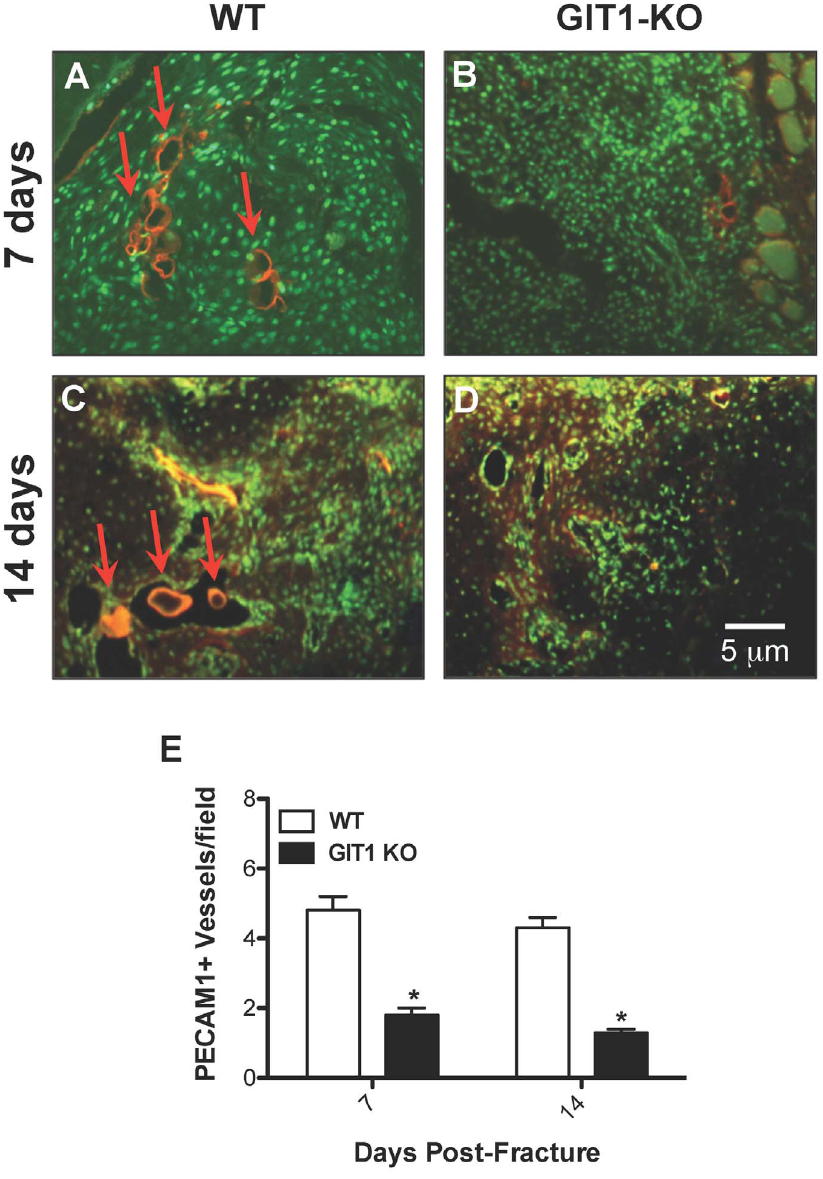
Figure 8. PECAM1 + blood vessel number is reduced in GIT1 KO mice. Representative PECAM1 immunofluorescence is presented at 7 and 14 days post-fracture in WT mice (A and C) and GIT1 2 / 2 mice (B and D). Histomorphometry was performed to quantify the average number of positively- stained blood vessels present in each field of view on each section analyzed. Three sections (from 3 levels within each callus, 25–50 m m apart) were viewed using the 10 6 objective, with counts being collected from 3 fields of view in each section. All counts from each callus (9 fields total) were averaged. Vessel counting using this approach confirmed the immunofluorescence in panels A–D, with WT calluses possessing between 2 and 3-fold more PECAM1 + vessels than GIT1 KO calluses at both time points (E). Bars represent mean number of PECAM1 + vessels/field + / 2 SEM (*p , 0.01, N=3).